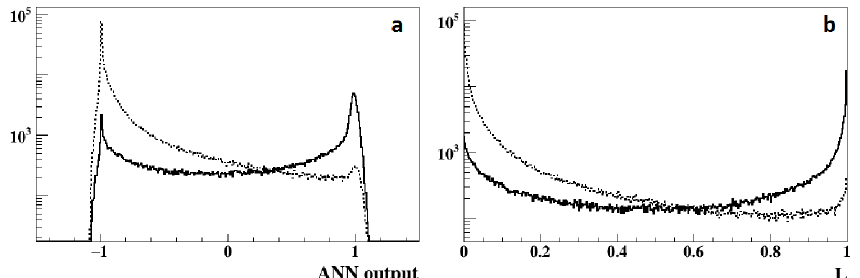
Figure 4. Distributions of the ANN output (a) and the variable L (b) for π + / − (dash line) and e + / − (solid line)